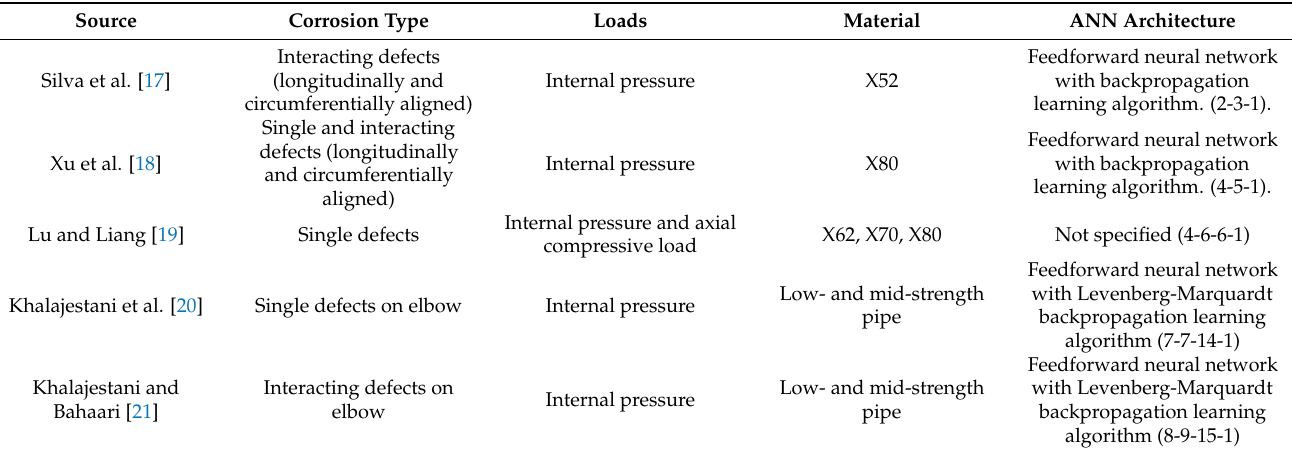
Table 1. Literature on ANN application using FEA dataset to predict failure pressure of corroded